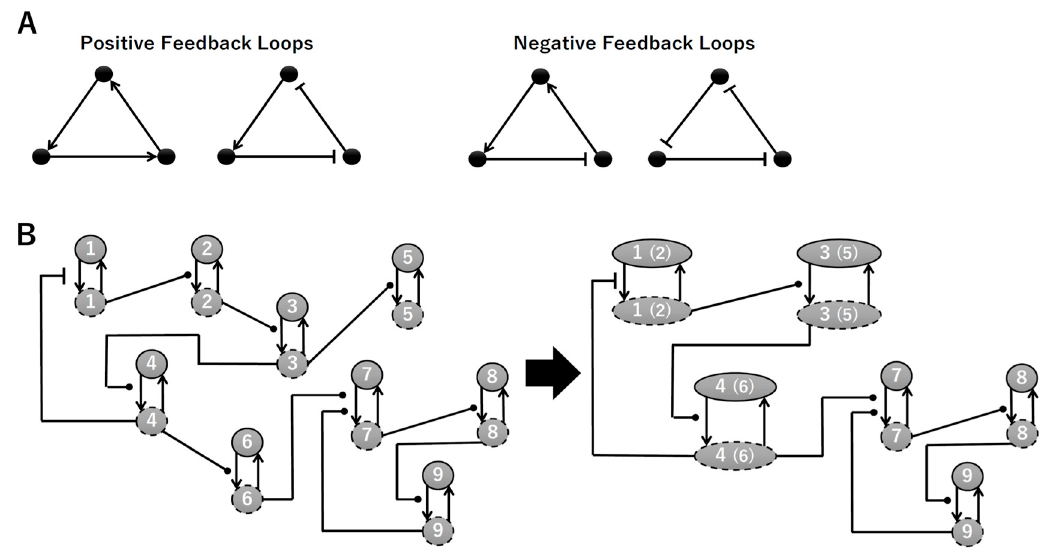
Figure 3. Feedback loops and contraction. ( A ) Examples of positive and negative feedback loops. ( B ) Example of contraction.